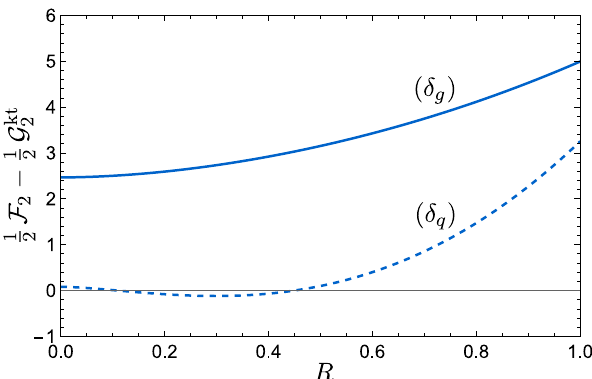
Figure 4 . Combined coefficient of CLs and NGLs at two loops for the two channels ( δ q ) and ( δ g ) .